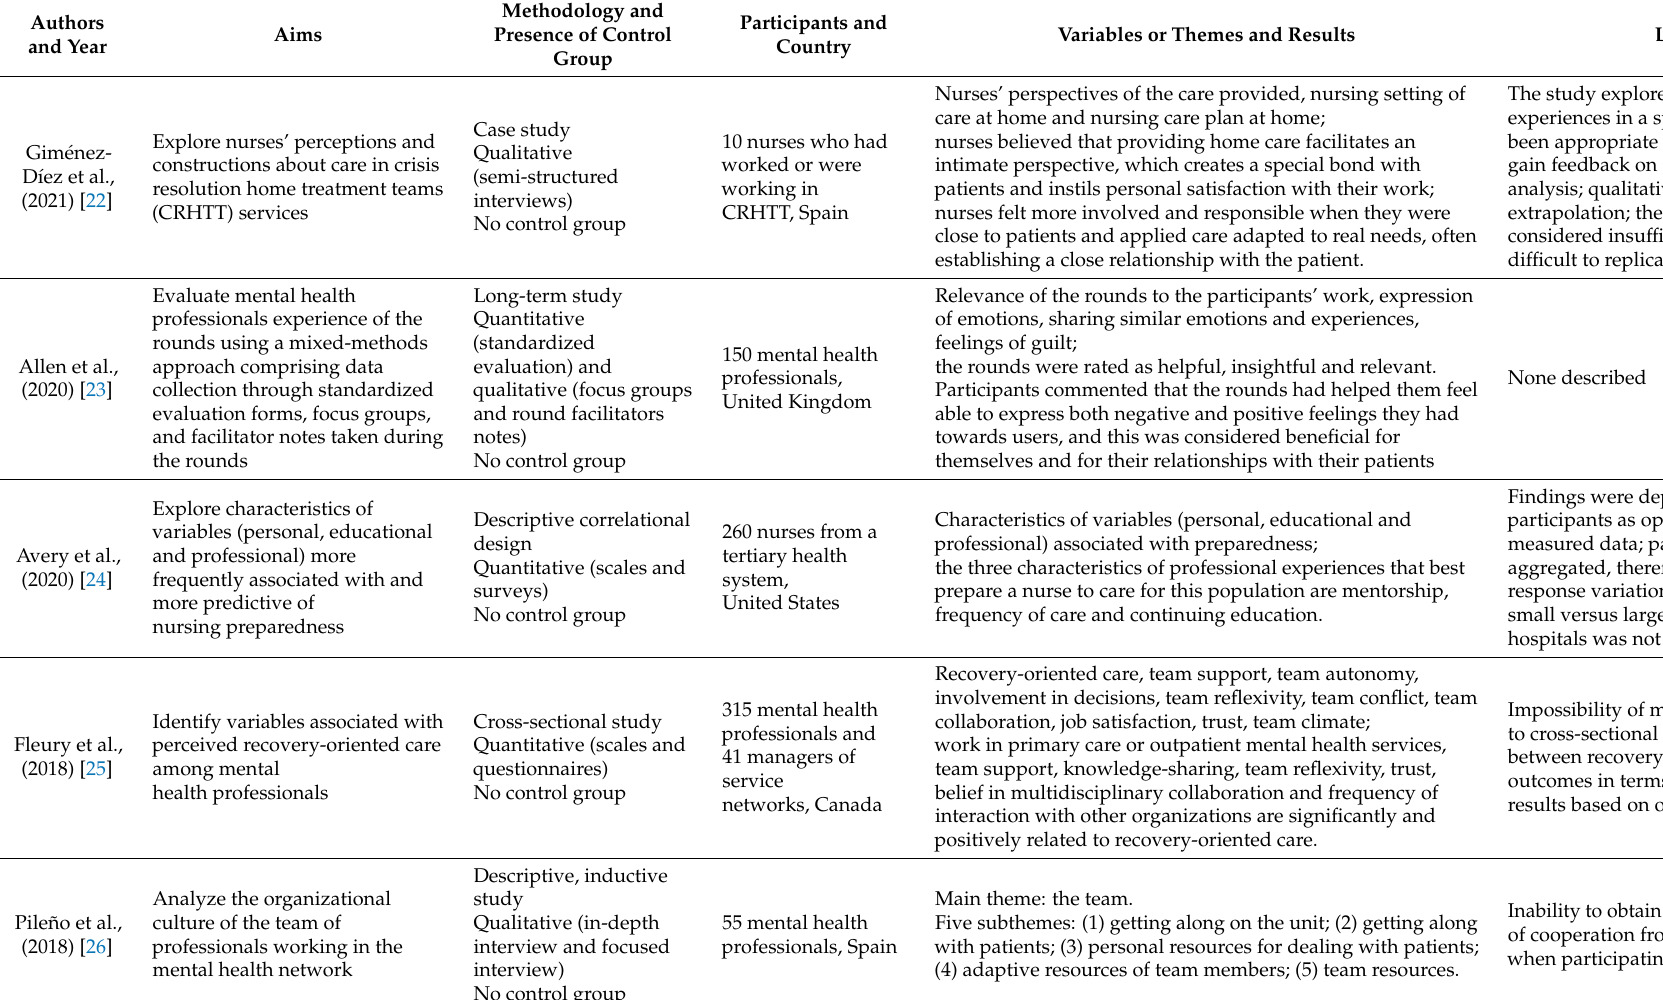
Table 1. Synthesis of the included